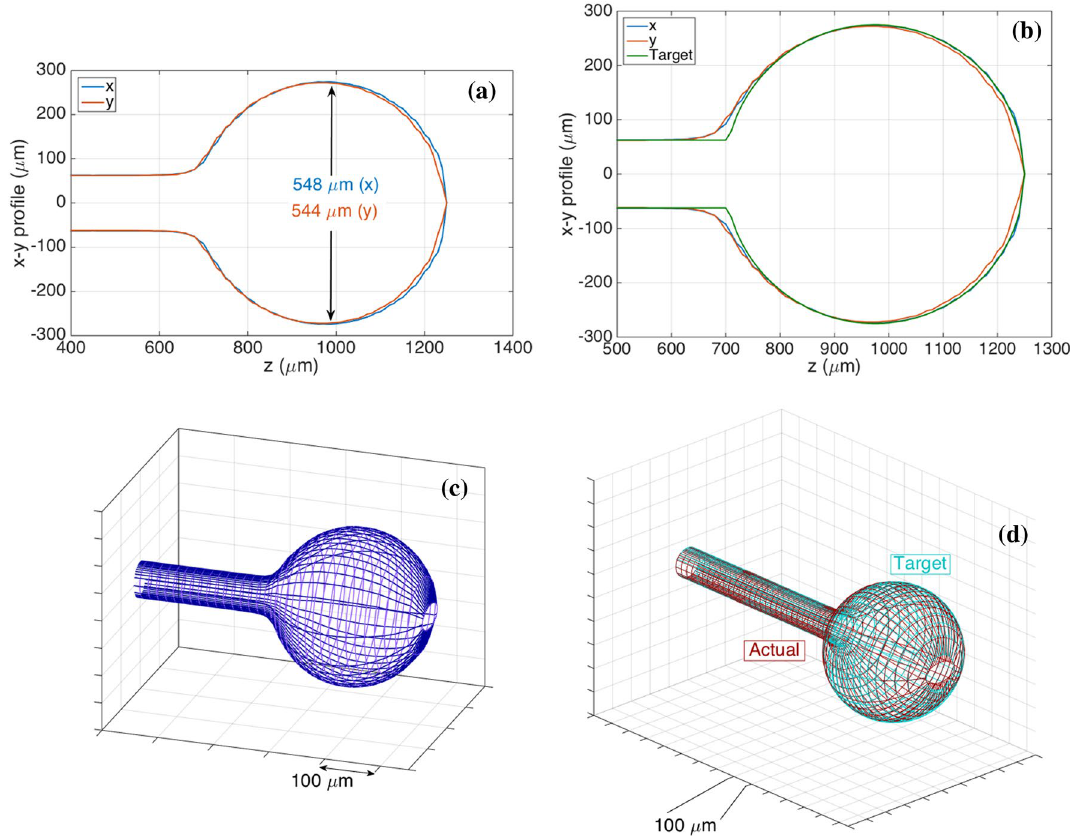
Figure 1. The geometrical profile of fiber optic spherical tip sensor (548–544 µm) used to detect CD44 protein in this work. (a,b) Two-sided profilometry of the fiber optic tips obtained from Fujikura splicer as measured by its inner microscope; where diameter on the horizontal and vertical axes (x, y) for each position along the fiber axis (z) is shown; (a) actual sensor (fabricated and used in experiments) and (b) actual sensor vs. target (i.e. designed profile for the splicing fabrication). (c,d) 3D profiles extrapolated from profilometry data by reconstructing the elliptical meshes of the tips: (c) actual sensor and (d) actual sensor vs. target; Ellipticity548-544 µm =